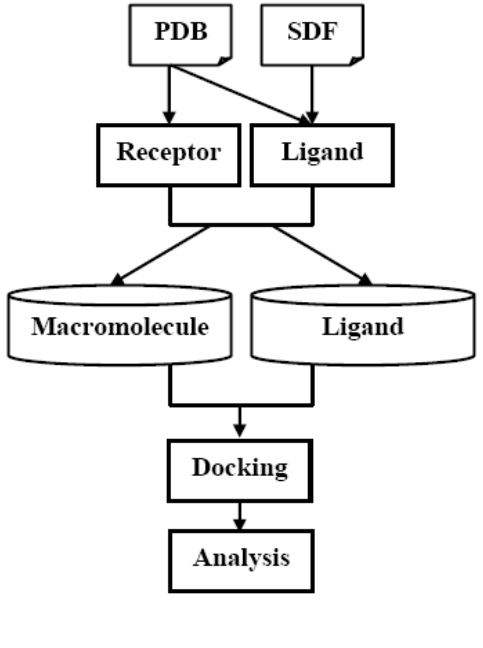
Figure 2. The basic virtual ligand screening